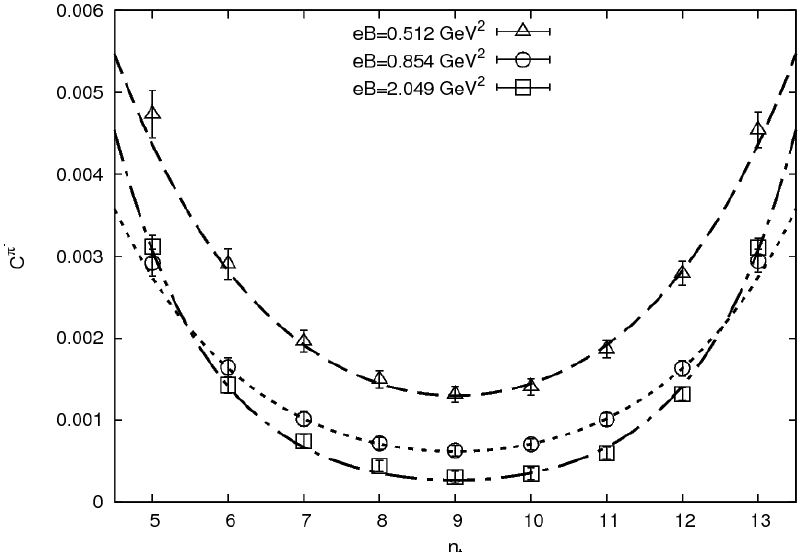
Figure 4 . The correlation function (8.7) versus n t for the lattice spacing 0 : 115 fm, lattice volume 18 4 and bare quark masses 17 : 13 MeV for several values of magnetic (cid:12)eld eB